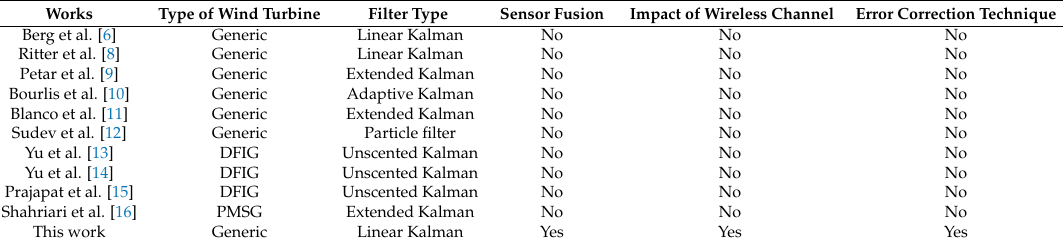
Table 1. Comparison of different works on state estimation of wind